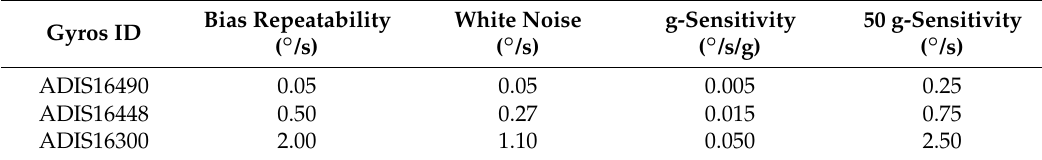
Table 1. Error parameters of three typical gyroscopes from ADI Co.,